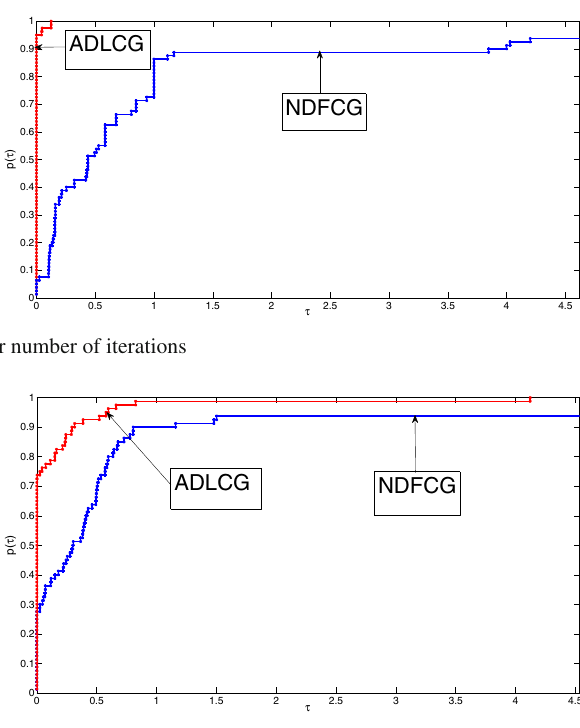
Fig. 2 Performance profile for the CPU